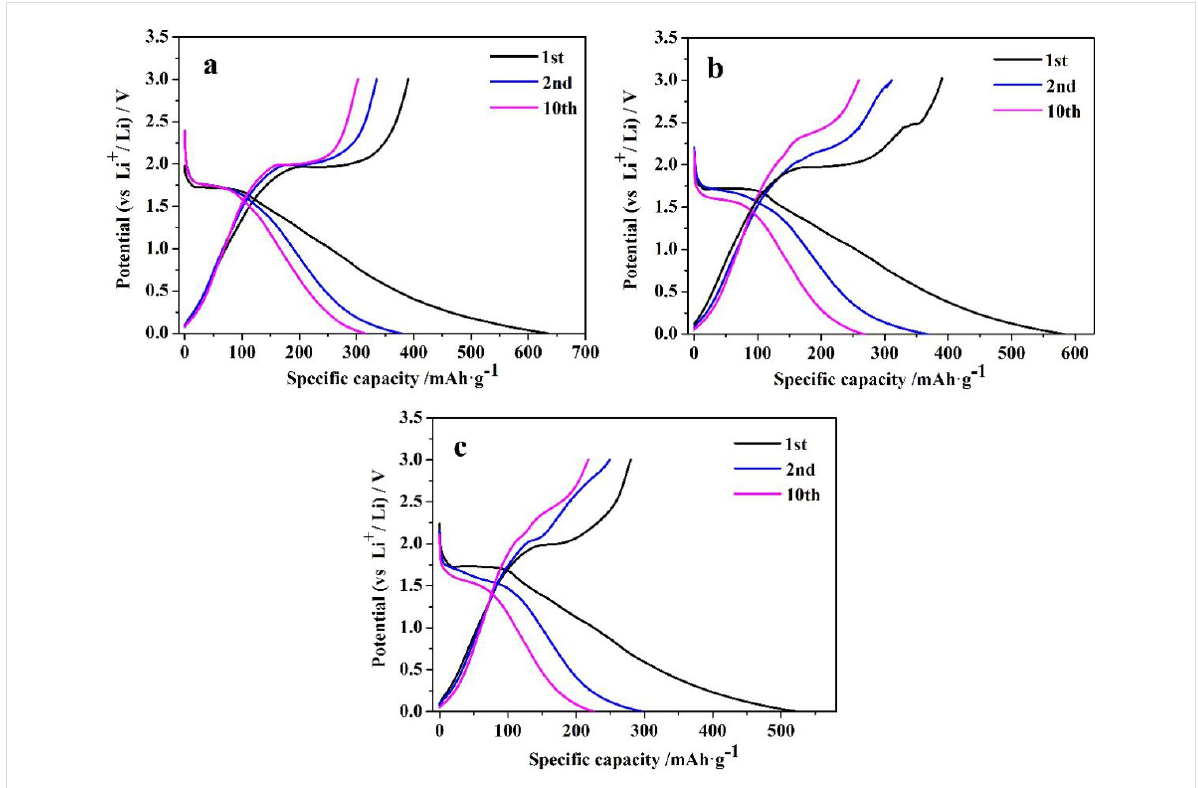
Figure 6: Galvanostatic charge–discharge curves of sample A 2 (a), sample B 2 (b) and sample C 2 (c) for the first ten cycles at the current density of 40 mA·g − 1 .